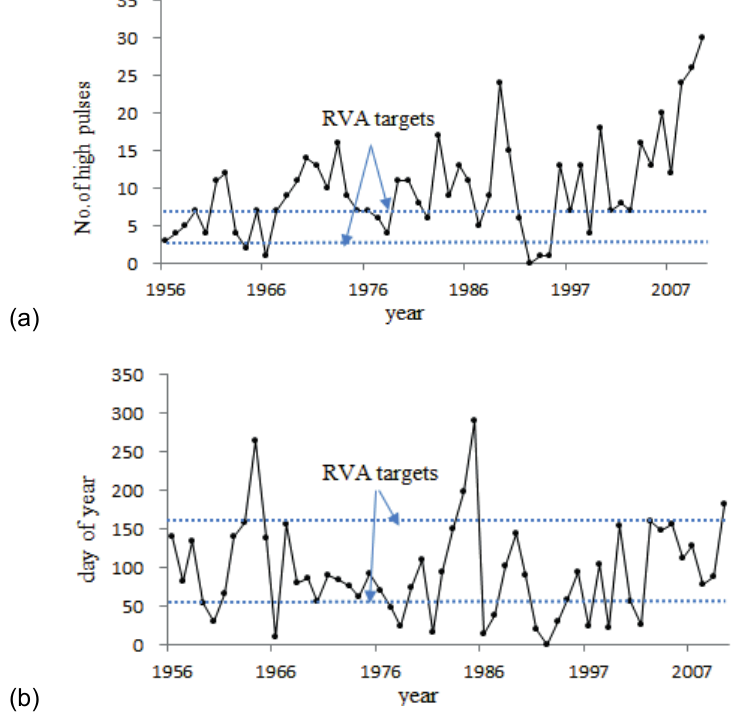
Fig. 4 Variation of times (a) and duration (b) of high pulse appeared pre and